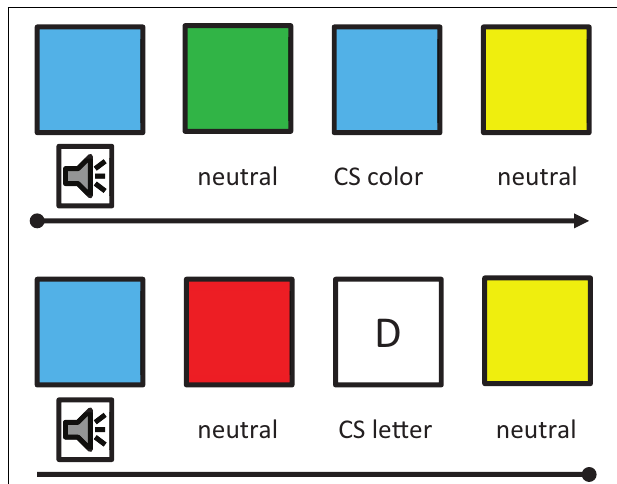
FIGURE 3 | Synaesthetic conditioning. In this particular example, the letter D was associated with blue during the training. That is, blue squares not followed by the startling sound acted as CS color and the letters as CS letter. The remaining colors were neutral. Each square represents one trial with the first trial in the upper left corner and the last trial in the lower right corner (moving from left to right). Adopted from Meier and Rothen (2009).